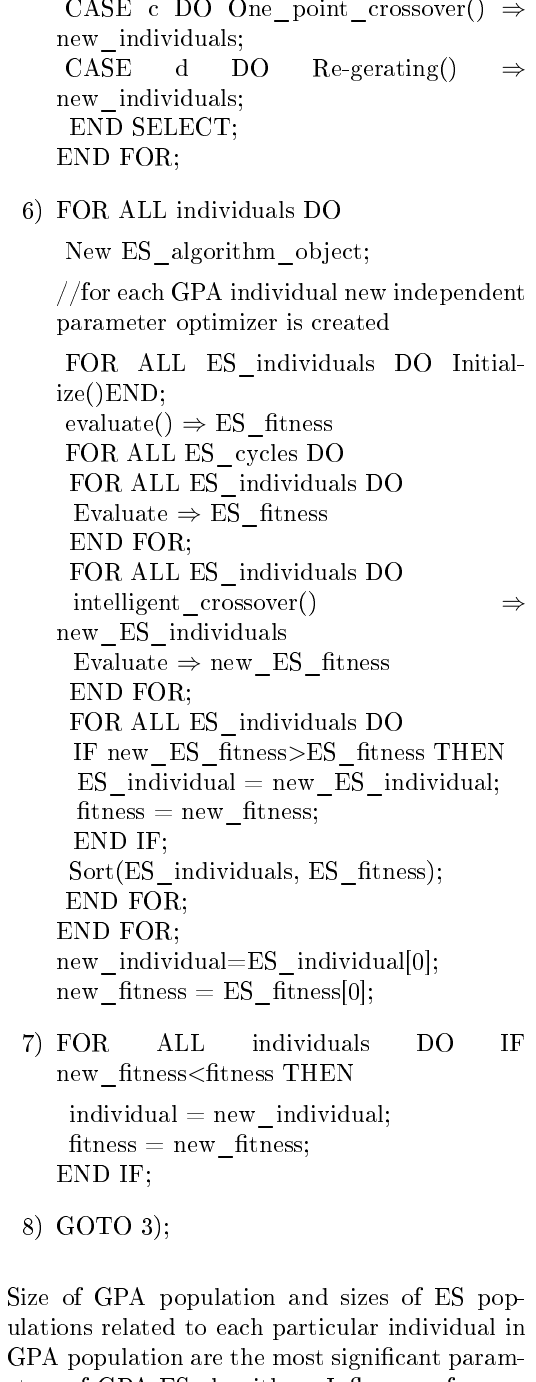
Algorithm 1. Studied GPA